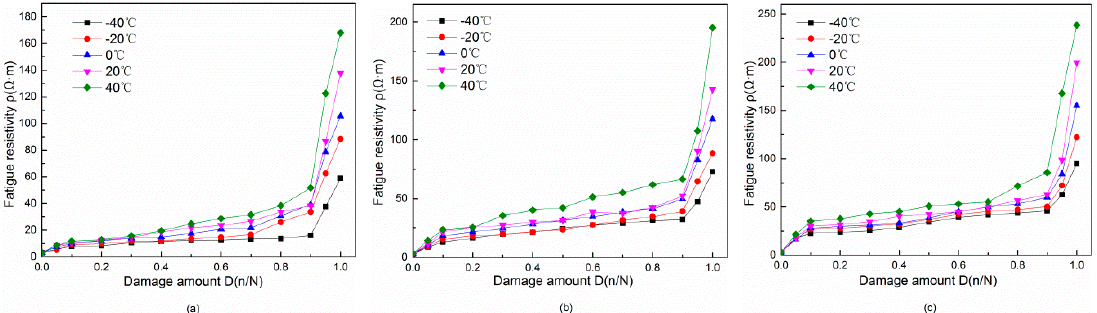
Figure 11. Fatigue resistivity evolution curve. ( a ) ρ -D curve at stress level 0.6; ( b ) ρ -D curve at stress level 0.7; ( c ) ρ -D curve at stress level 0.8.